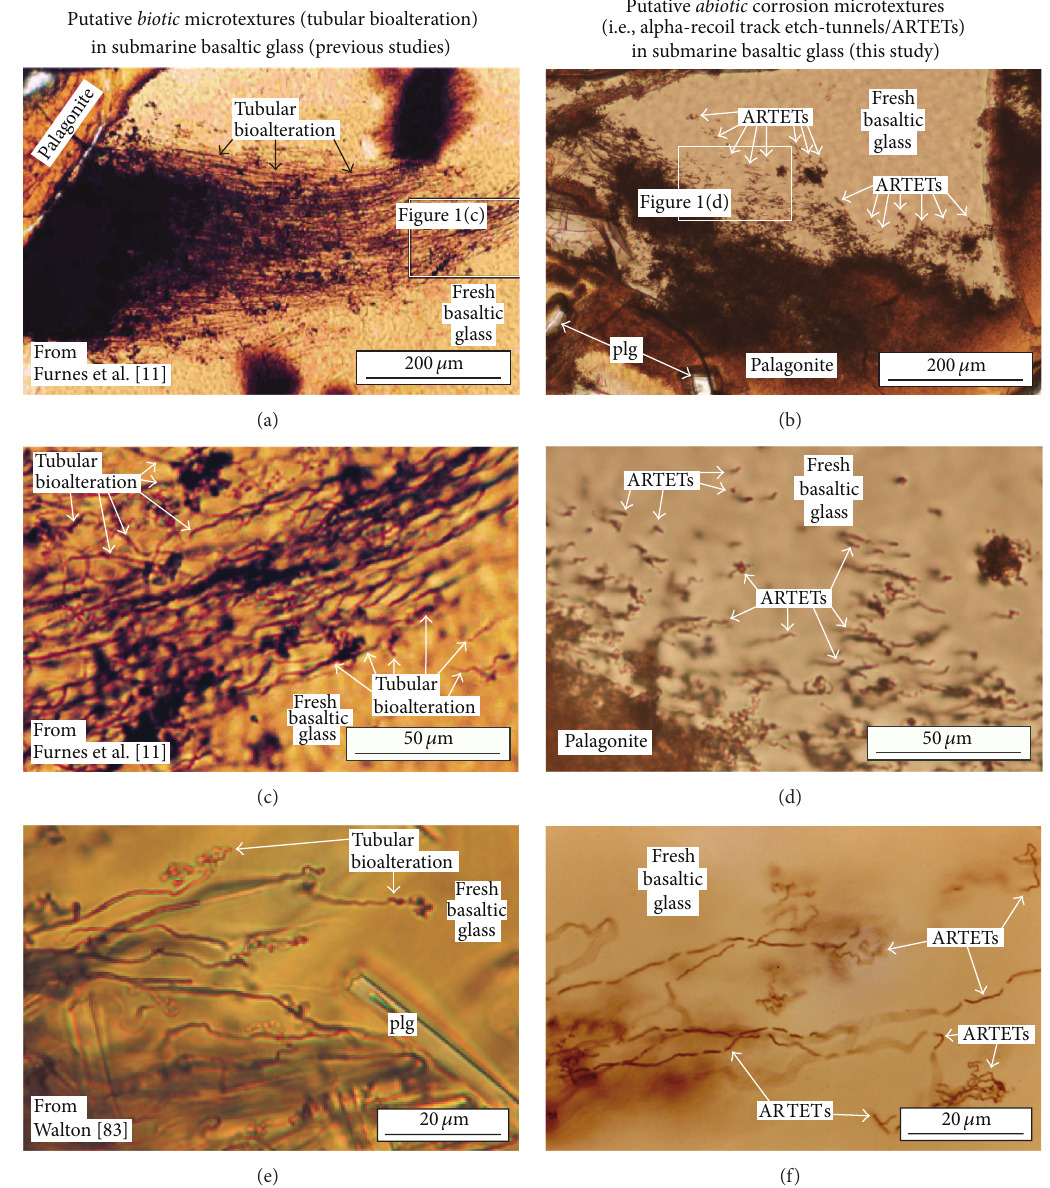
Figure 1: Scale comparisons (1: 1) of previously reported “tubular” bioalteration microtextures in submarine basaltic glass (a, c, and e) with abiotic corrosion microtextures (alpha-recoil track etch-tunnels) in DSDP 418A basaltic glass (this study) (b, d, and f). All images (a–f) are photomicrographs of polished petrographic sections of submarine basaltic glasses taken in plane polarized light (uncrossed nicols). (a) and (c) are from [11] (sample DSDP-418A-62-4-[64–70] ), and (e) is from [83] (Hawaii Scientific Drilling Project (HSDP) sample 4656.7). (b) and (d) are from sample DSDP-418A-68-3[40–43] , and (f) is from sample DSDP-418A-75-3[120–123] . Note the similarities when comparing (a), (c), and (e) to (b), (d), and (f), respectively, despite the differences in their inferred origin (biotic versus abiotic). ARTETs: alpha-recoil track etch-tunnels; plg: plagioclase